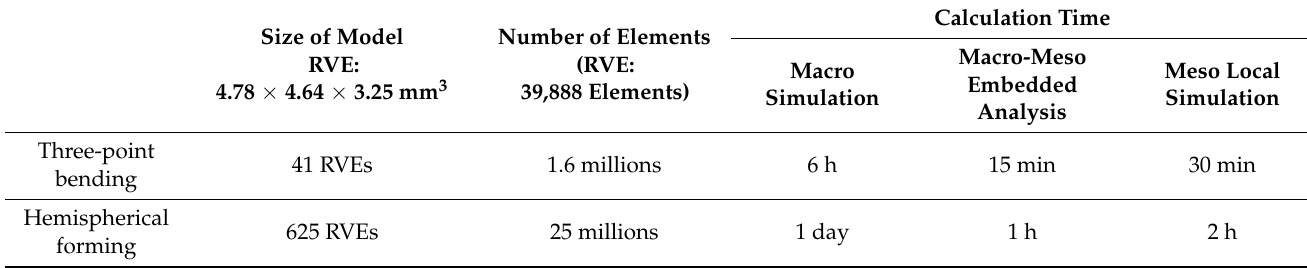
Table 1. Calculation time of three-point bending and hemispherical